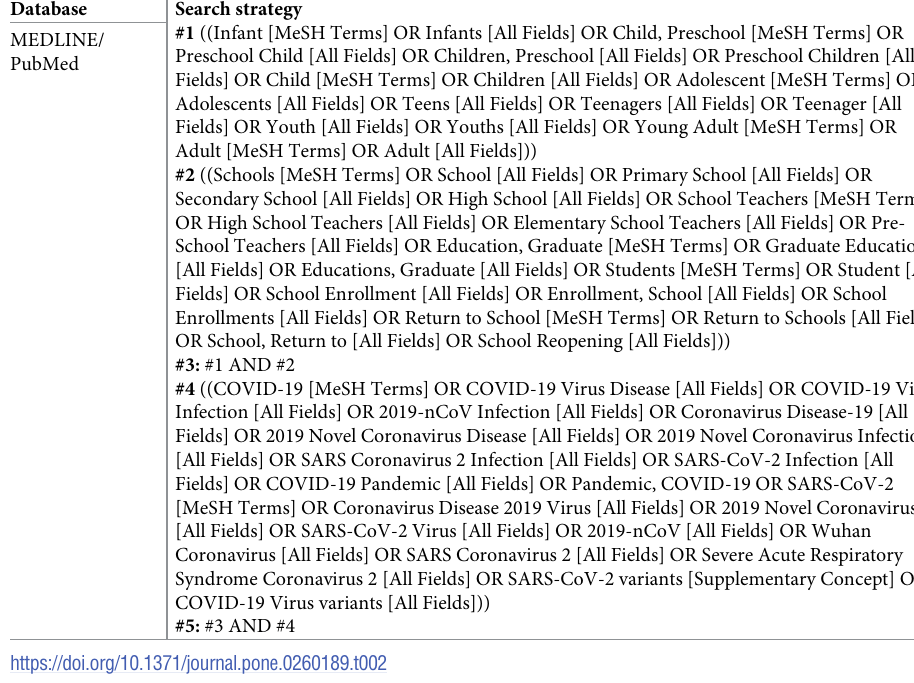
Table 2. Preliminary pilot search strategy in MEDLLINE/PubMed.